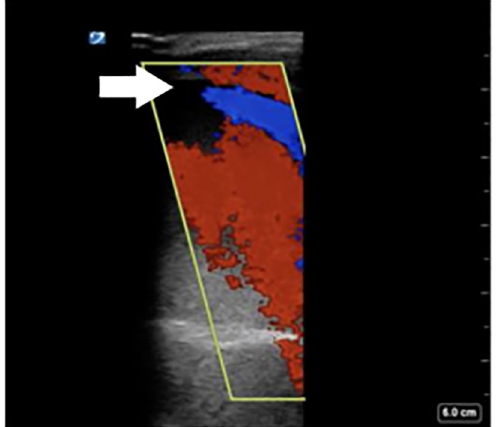
Image 6b. Color Doppler demonstrates swirling clockwise flow